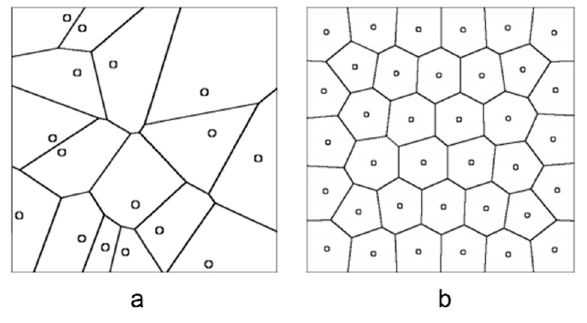
Figure 2. Voronoi diagrams: ( a ) Voronoi diagram of original seed points; ( b ) centroidal Voronoi diagram.